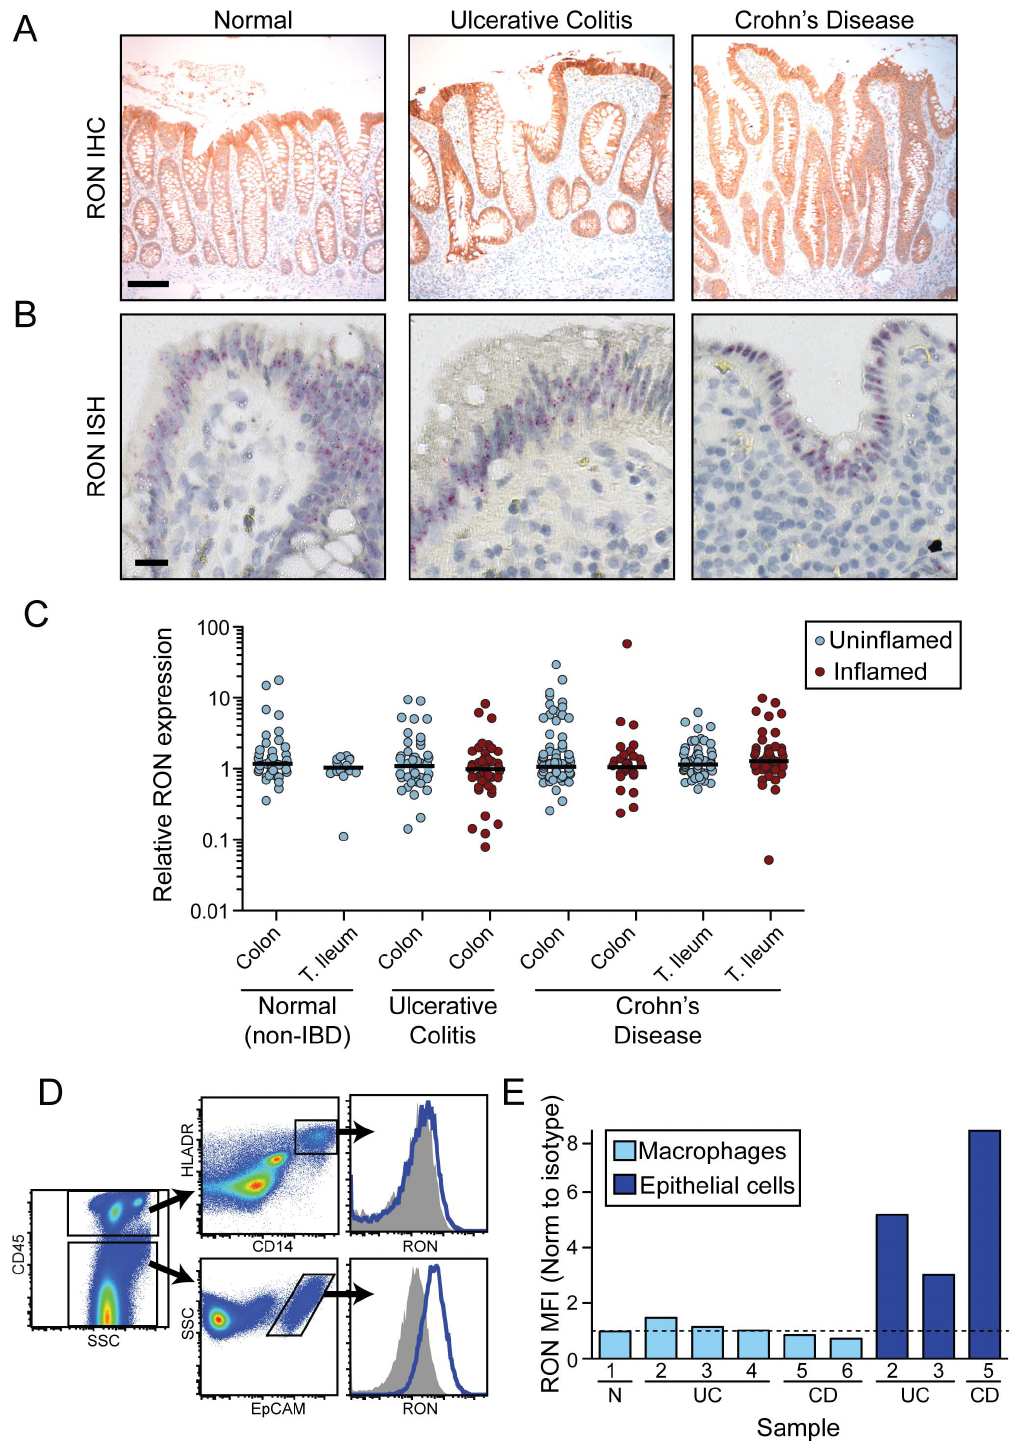
Figure 3. RON is preferentially expressed by epithelial cells in human tissues under steady-state and disease conditions. (A) Representative images from IHC analysis of RON protein expression (brown) on tissue sections from normal, UC, and CD colons. Scale bar = 100 m m. (B) Representative images from ISH analysis of RON transcript expression (red) on tissue sections from normal, UC, and CD colons. Scale bar = 20 m m. (C) Quantitative RT-PCR analysis of RON expression in human intestinal biopsies samples taken from normal individuals and uninflamed and inflamed regions of UC and CD patients. (D) Analysis of RON expression in single cell suspensions of resected intestinal tissues from an ulcerative colitis patient by flow cytometry using a monoclonal antibody specific for human RON (blue histogram) or an isotype control antibody (shaded histogram). Macrophages were gated as CD45 + CD14 + HLADR + and epithelial cells were gated as CD45 2 EpCAM + cells. (E) Quantification of RON expression by flow cytometry on macrophages and epithelial cells from resected intestinal tissue of multiple donors (macrophages: 1 non-IBD (N), 3 UC, 2 CD; epithelial cells: 2 UC, 1 CD). Patient numbers are indicated (Table S1). Data represents the mean fluorescence intensity (MFI) ratio of RON staining to isotype